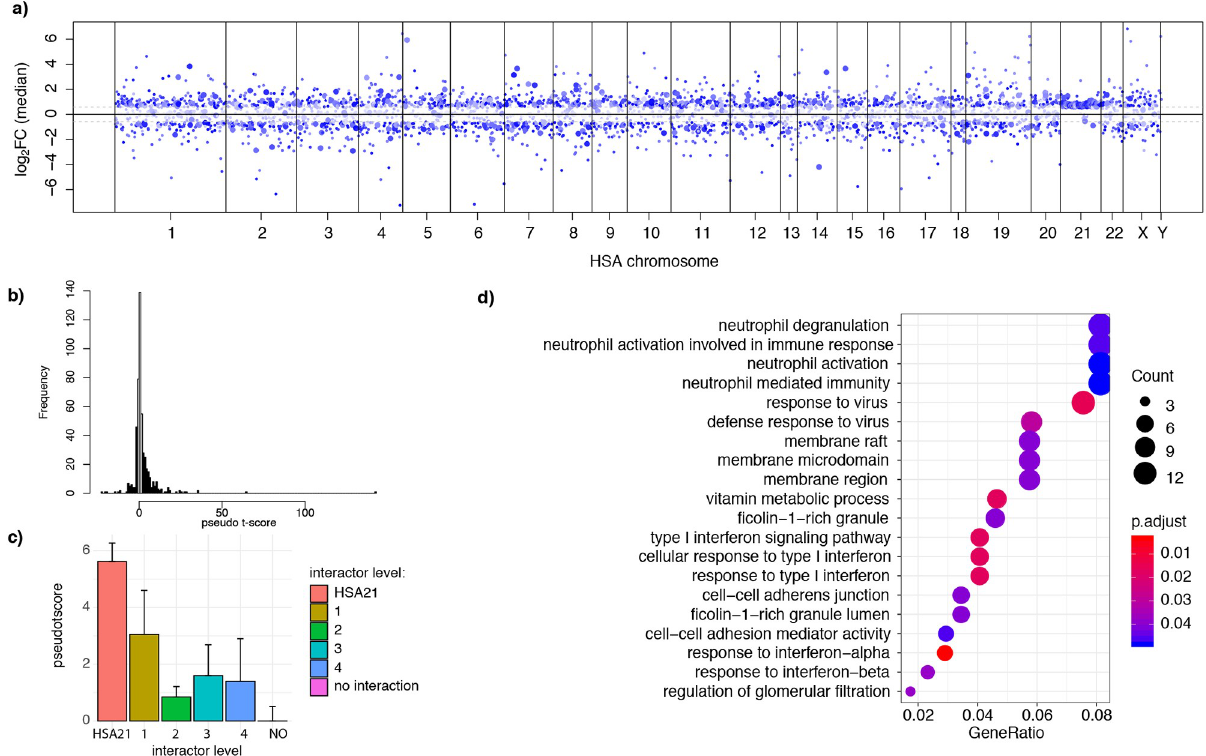
Fig 4. Genes with consistent upregulation are enriched in interferon-related categories and neutrophil activation. a) Manhattan plot where each dot is a gene deregulated in DS, the level of opacity indicates the pseudo t-score. The top 500 DE genes are plotted in bigger size. b) Distribution of pseudo-t-scores. The consistently up-regulated and down-regulated genes are in black. c) Barplot showing the average pseudo-t-score in HSA21 genes, their primary, secondary, tertiary interactors, and the other proteins of the network d) Gene ontology analysis for the genes with high absolute pseudo- t-score (in black in